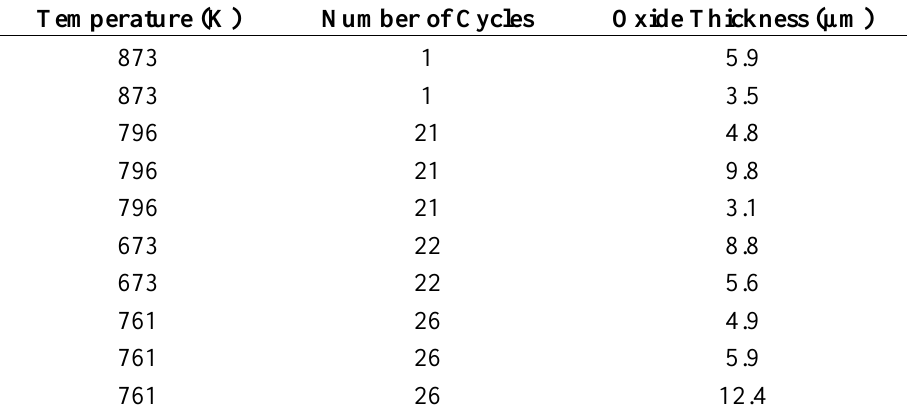
Table 1. Oxidation terminated experimental conditions, number of redox cycles, and corresponding measured average oxide layer thickness.